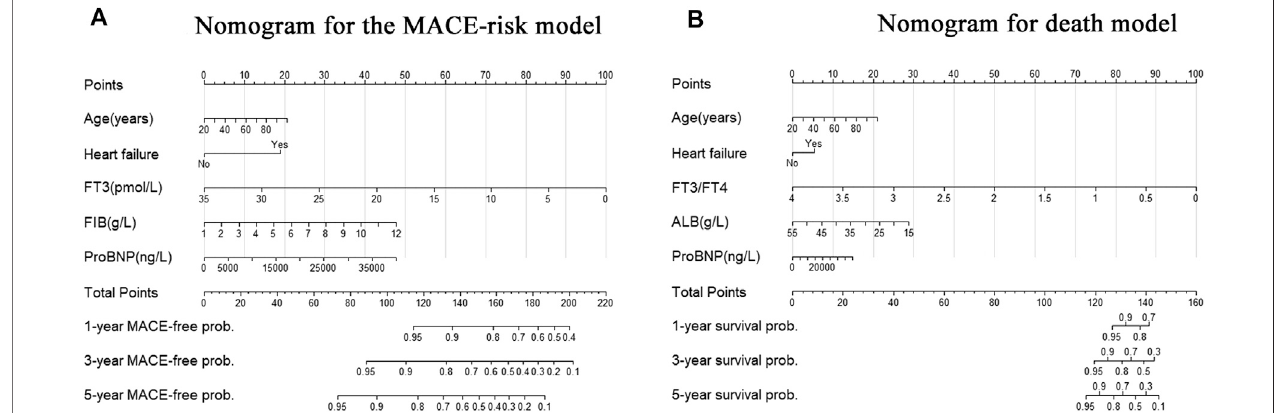
FIGURE 4 | Nomogram for the new biomarker-based risk score. (A) Nomogram for the fi nal biomarker-based ABC-MACE risk score; (B) Nomogram for the fi nal biomarker-basedABC-deathriskscore.Note:Thescoresofeachvariablewereaddedtoobtainthetotalscore,andaverticallinewasdrawnonthetotal scoretoobtain the corresponding probability of outcomes.